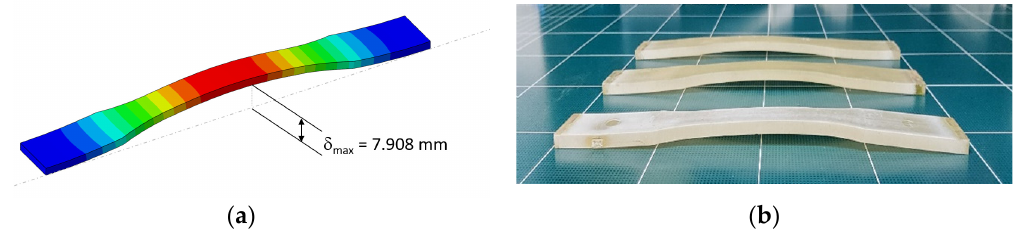
Figure 6. ( a ) Vertical deflection contour at temperature rise, and ( b ) thermal cyclic deformed speci- men.